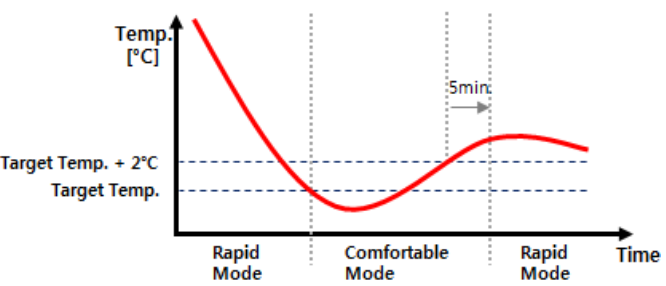
Figure 13. Smart-care operation—temperature graph.